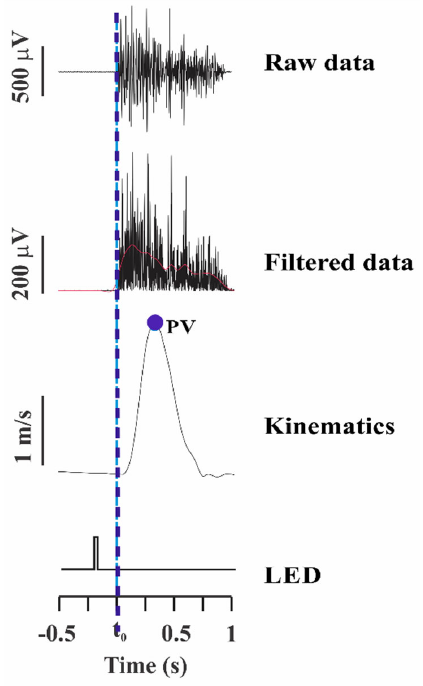
Figure 2. Illustration of deltoid muscle activation, raw and filtered data at 100 Hz low-pass. In addition, the marking of the velocity peak from the indicator trajectory is demonstrated, as well as the detection of the beginning of deltoid activation (T0, represented by the blue line), after stimulation performed with LED. LED: light emitting diode.